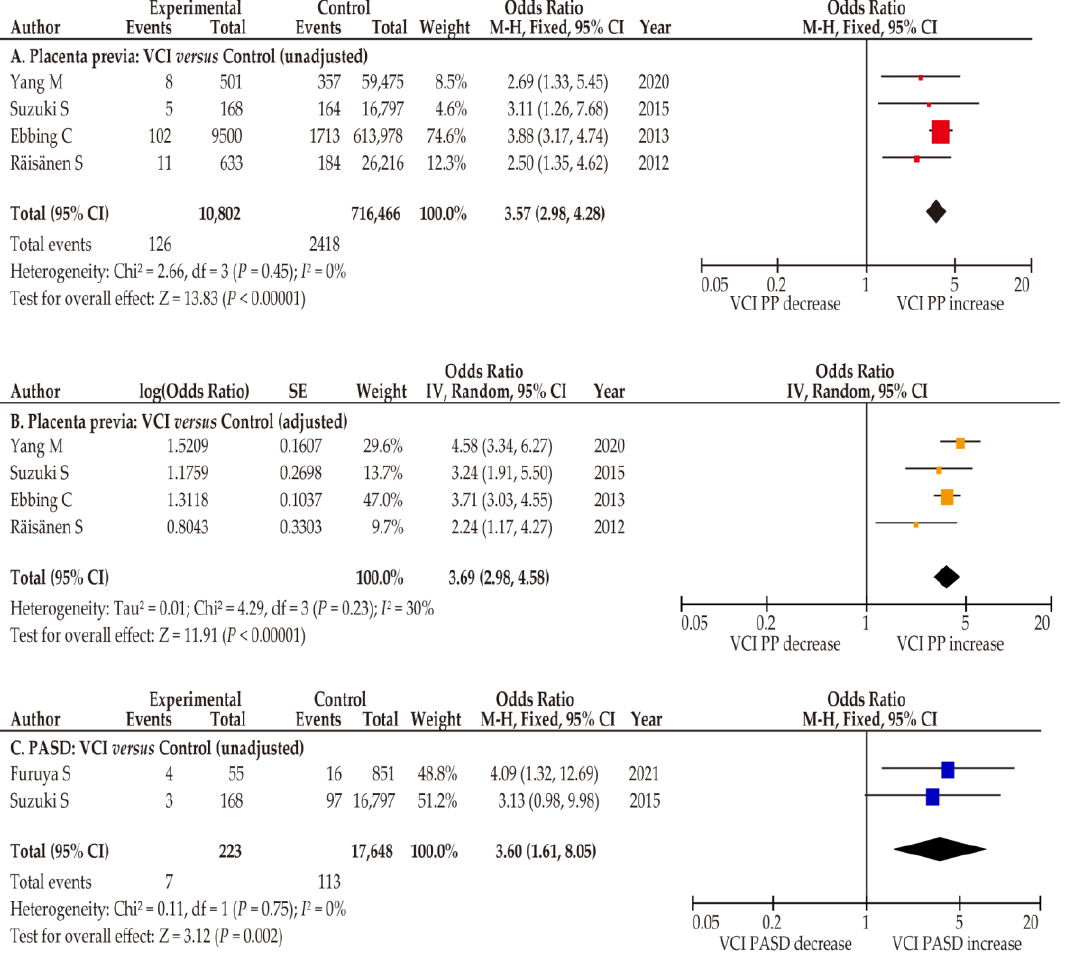
Figure 5. Effect of VCI on the prevalence of abnormal placentation. Pooled odds ratios (ORs) were calculated using RevMan version 5.4.1 (Cochrane Collaboration, Copenhagen, Denmark). Thus, some values may be slightly different from the original values. The effect of VCI on the incidence of abnormal placentation was determined. No heterogeneity was observed during the unadjusted analysis (A and C: I 2 = 0%), and fixed-effects analyses were performed. Moderate heterogeneity was observed in the adjusted analysis (B, I 2 = 30%), and a random-effect analysis was conducted. ( A , B ) Comparison of rates of placenta previa between women with and without VCI; ( C ) comparison of the prevalence of PASD between women with and without VCI. Abbreviations: VCI, velamentous cord insertion; PP, placenta previa; PASD, placenta accreta spectrum disorder; OR, odds ratio; CI, confidence interval; SE, standard error.